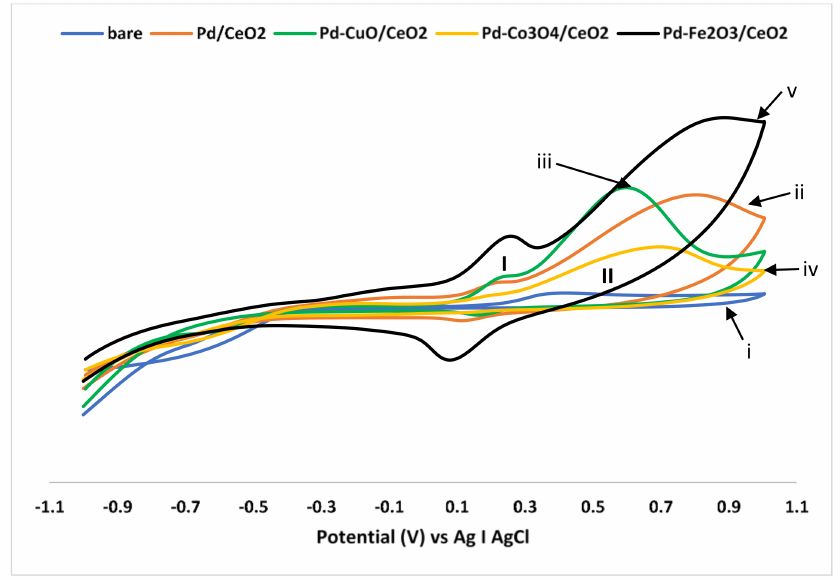
Figure 4. The CV response of GCE- ( i ) bare ( ii ) Pd/CeO 2 , ( iii ) Pd-CuO/CeO 2 , ( iv ) Pd-Co 3 O 4 /CeO 2 , and ( v ) Pd-Fe 2 O 3 /CeO 2 catalysts in 1M KOH. Scan rate = 100 mV/s. Process I is the Ce 3+ /Ce 4+ redox process and Process II is an irreversible process due to the oxidation of Pd.